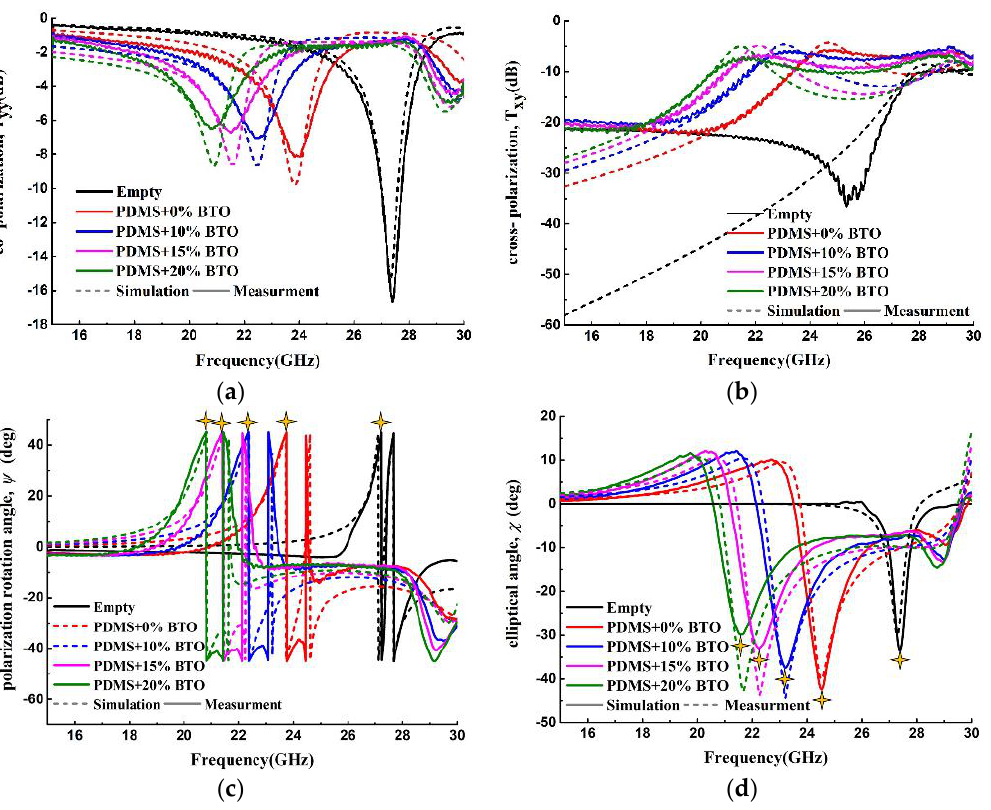
Figure 6. Simulated and measured curves of the ( a ) co- and ( b ) cross-polarization transmission coefficients, and the ( c ) PRA and ( d ) EA, varying with the volume fraction of BTO, respectively.